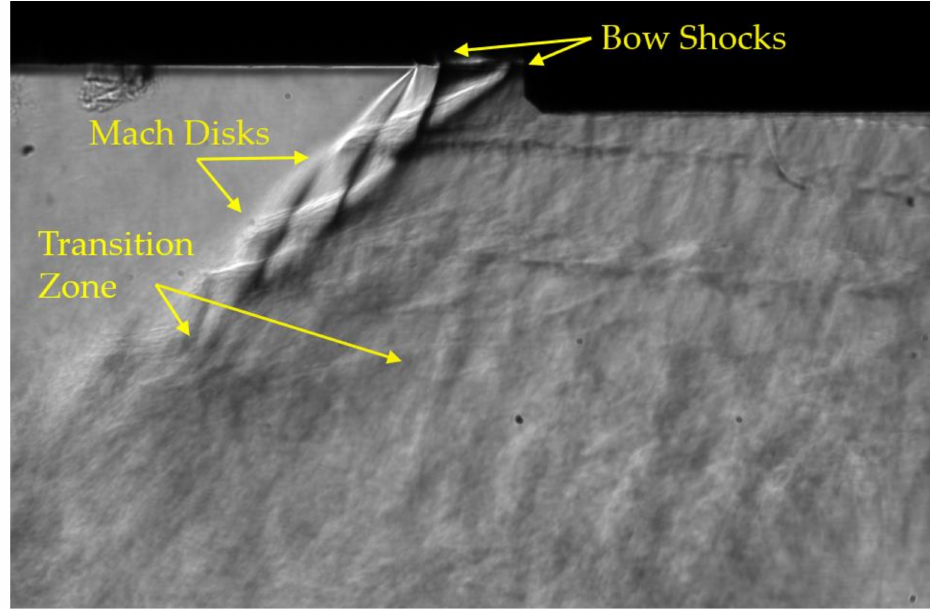
Figure 11. Schlieren of air jet ‘curtain’ created around poppet valve in first optical setup, at 5.0 MPa and 1 mm valve